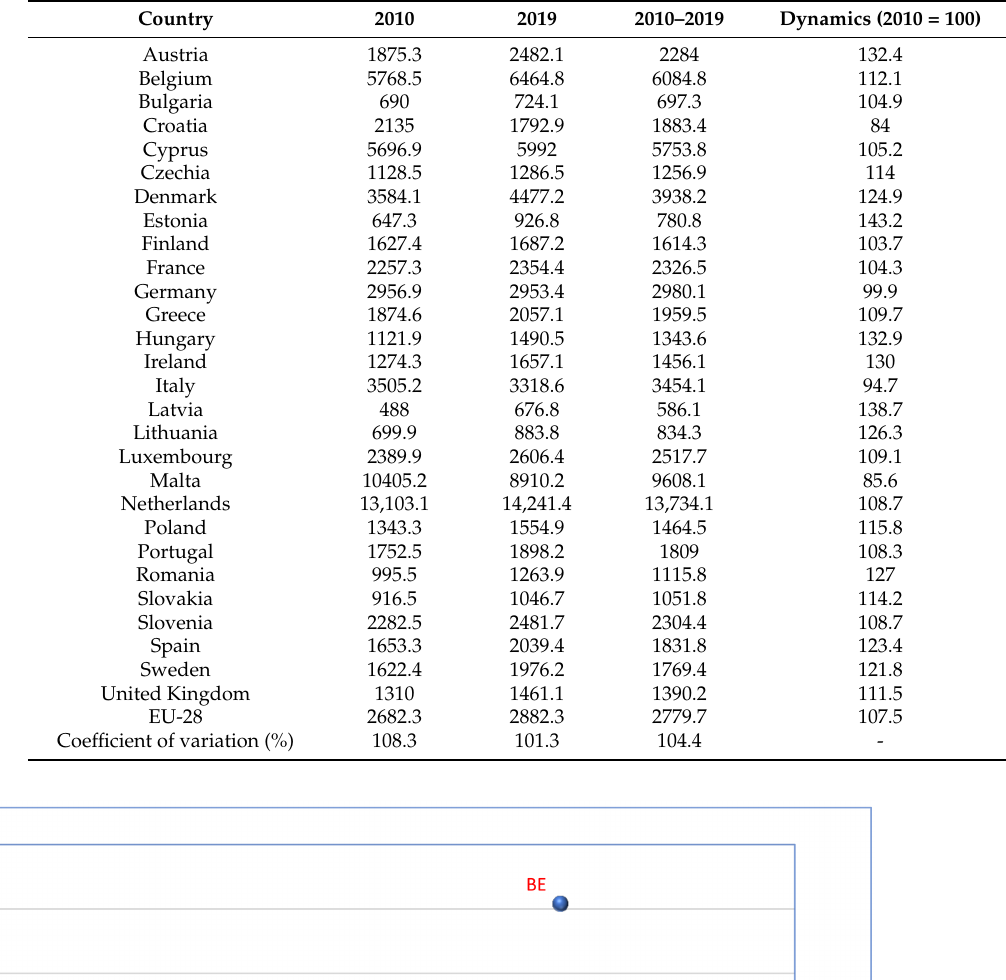
Table 4. Land productivity in the member states of the European Union from 2010 to 2019 (EUR per 1 ha).